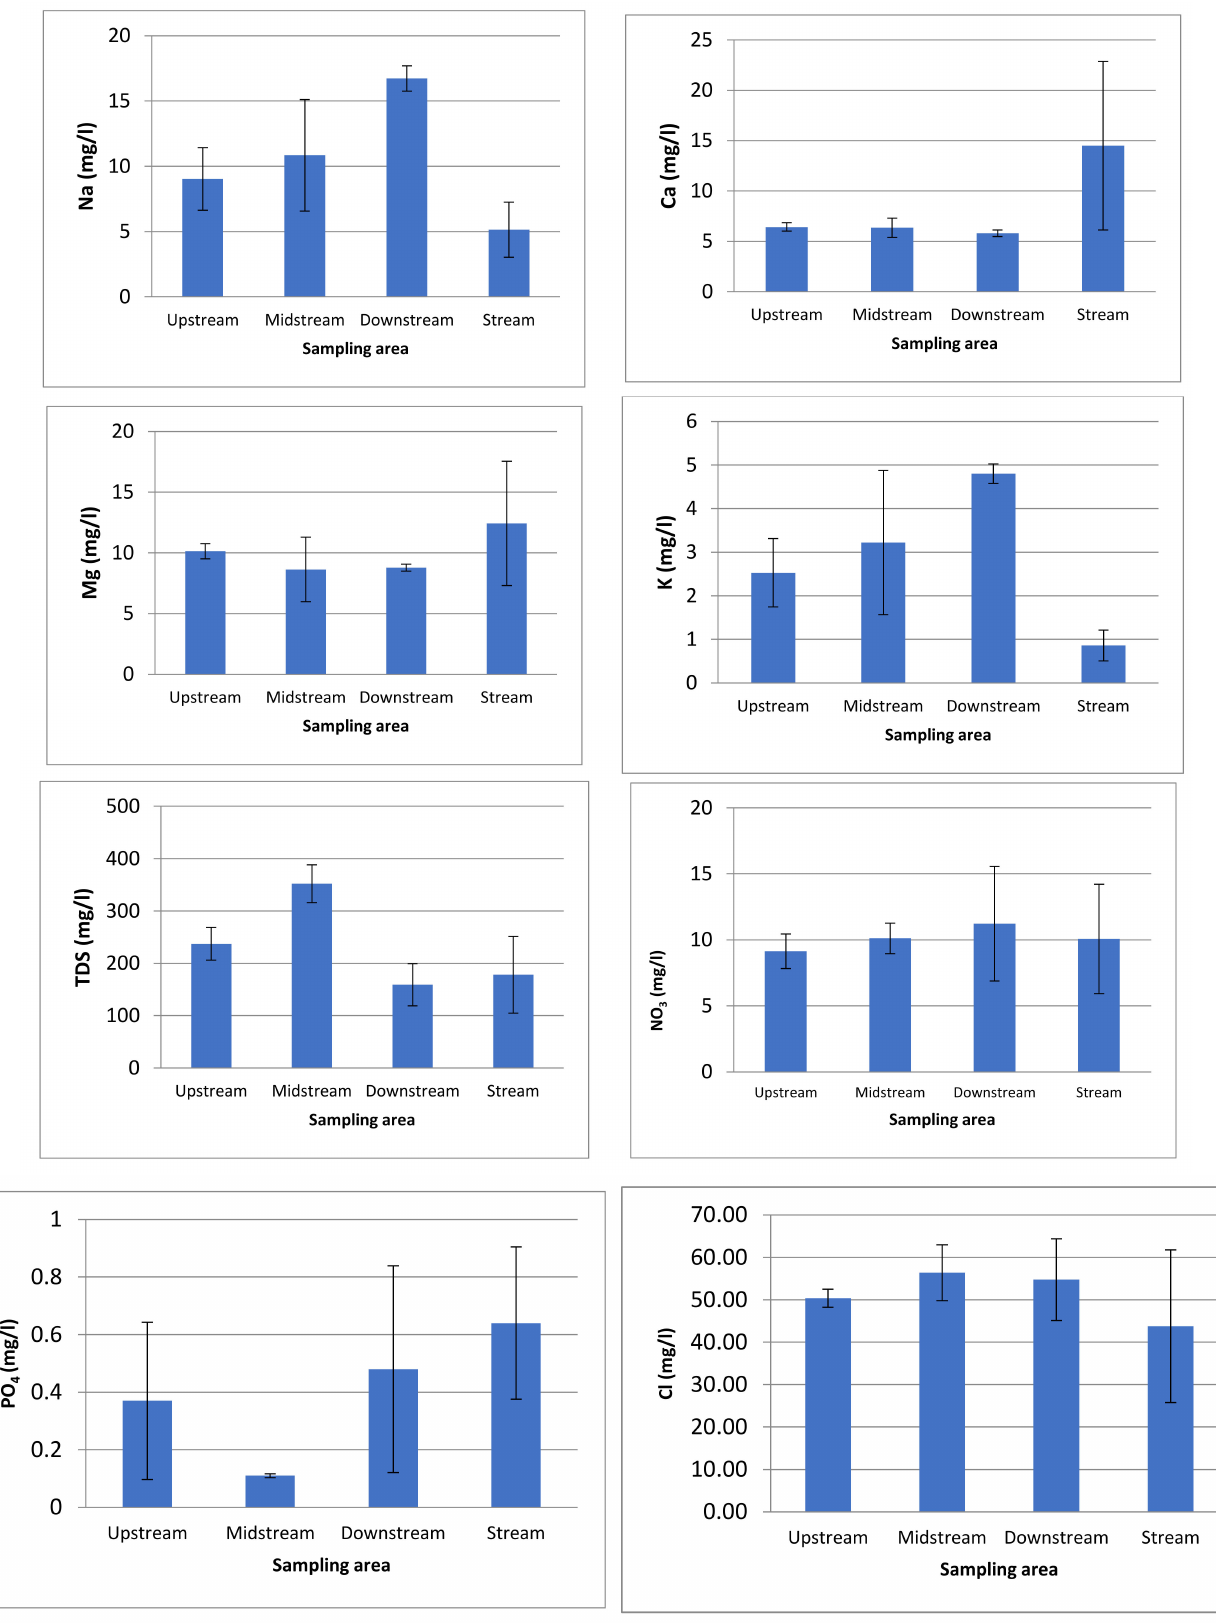
Figure 3. Averages of nutrient content upstream, midstream, and downstream of the wetland, as well as the Khubelu